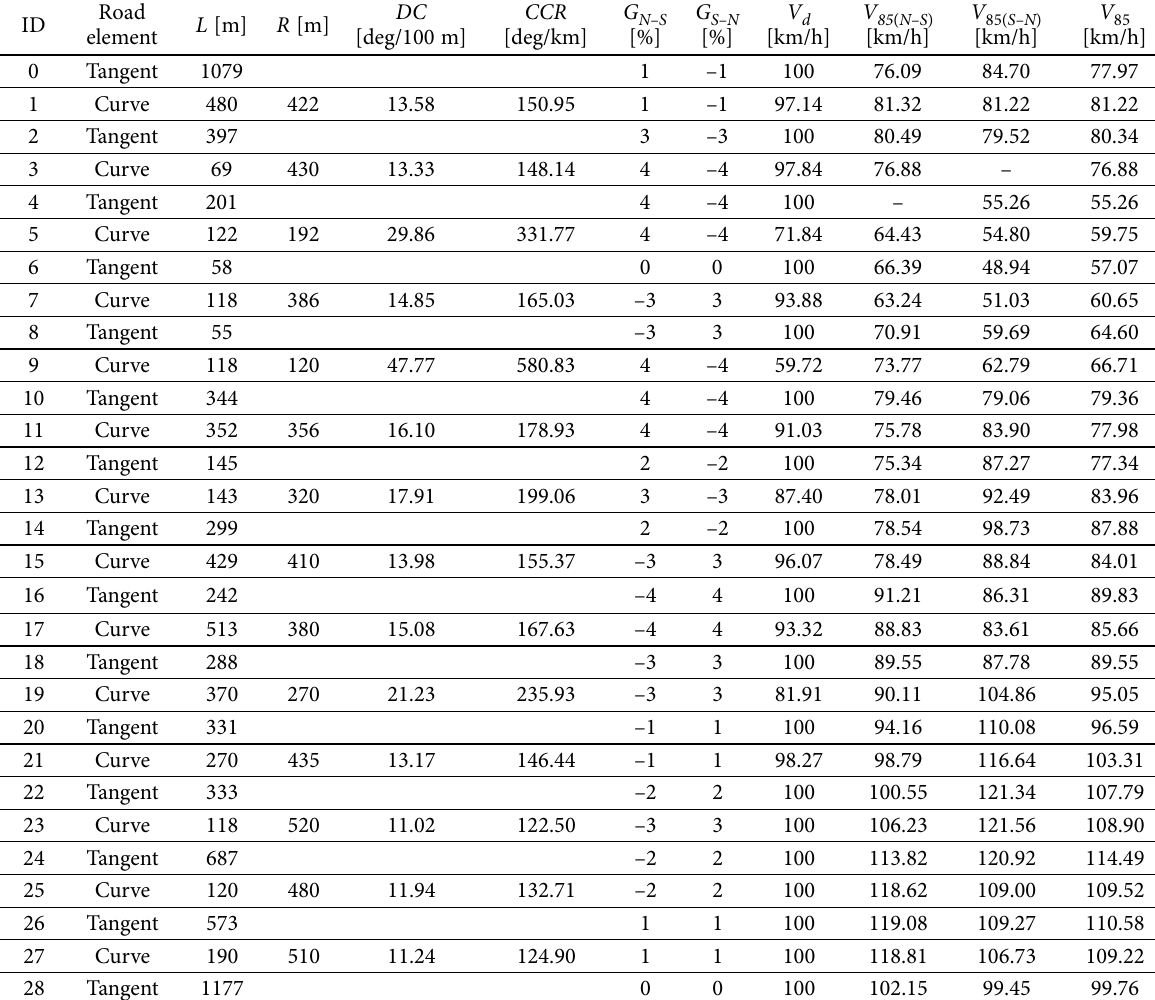
Table 1. Characteristics of the road